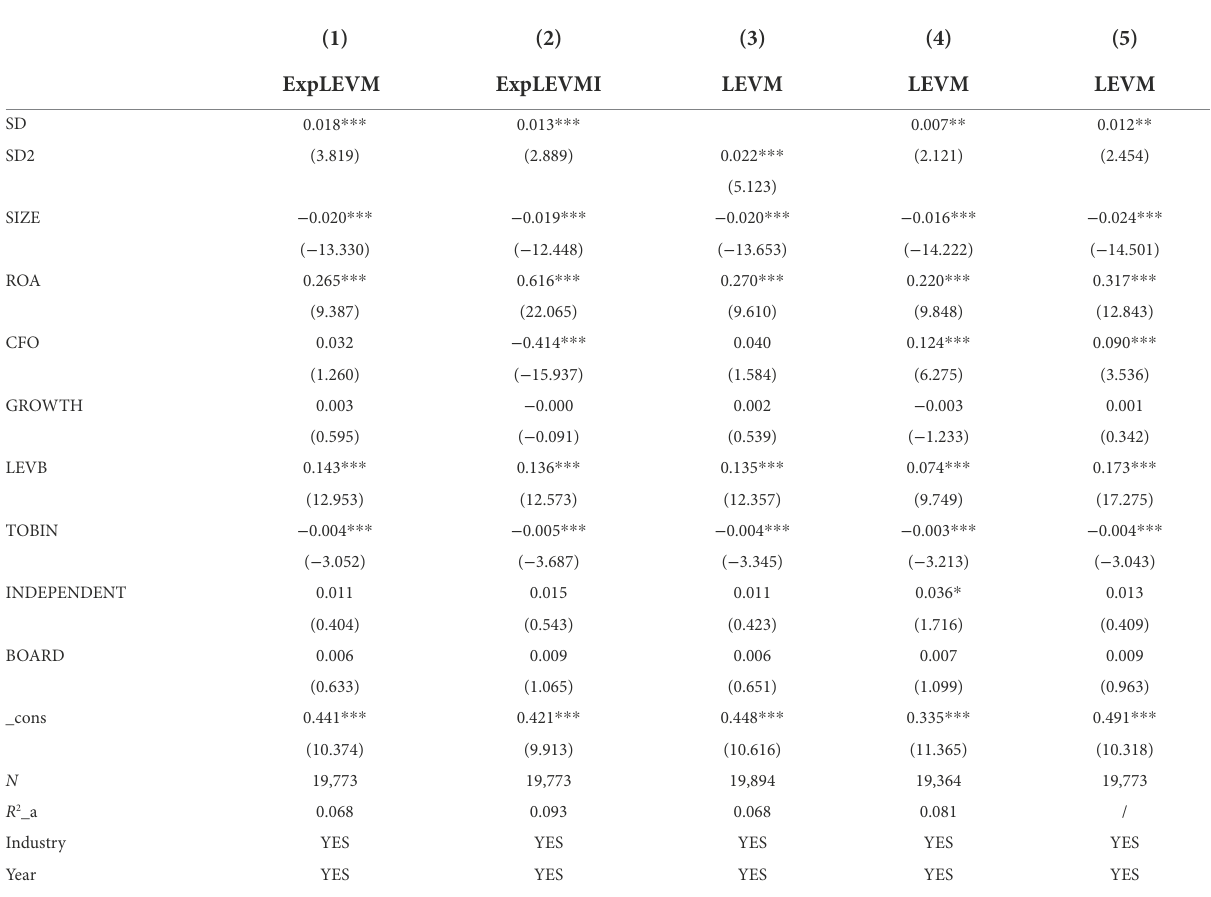
TABLE 15 Results of other robustness